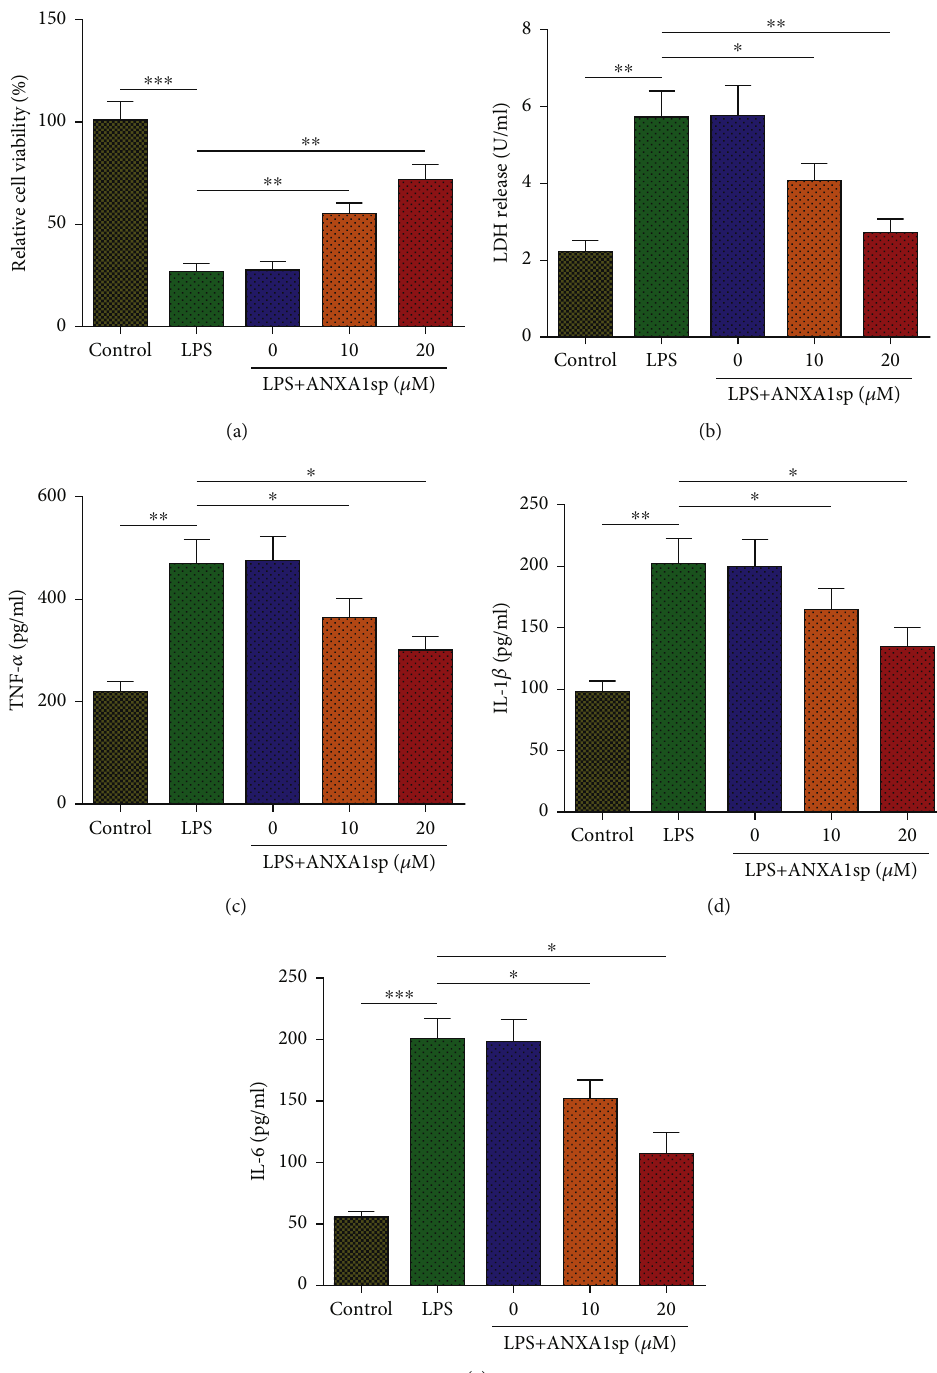
Figure 1: ANXA1sp inhibits LPS-induced H9C2 cell damage. H9C2 cells were assigned to control, LPS, and LPS+ANXA1sp groups. (a) CCK-8 for H9C2 cell viability. (b) LDH level in H9C2 cell supernatant. (c – e) ELISA for TNF- α , IL-1 β , and IL-6 levels in H9C2 cell supernatant. The experiments were repeated three times ( n = 3 ). Data were presented as mean ± SD . All statistical analyses were performed using Student ’ s t -test or one-way ANOVA. ∗ p < 0 : 05 ; ∗∗ p < 0 : 01 ; ∗∗∗ p < 0 : 001